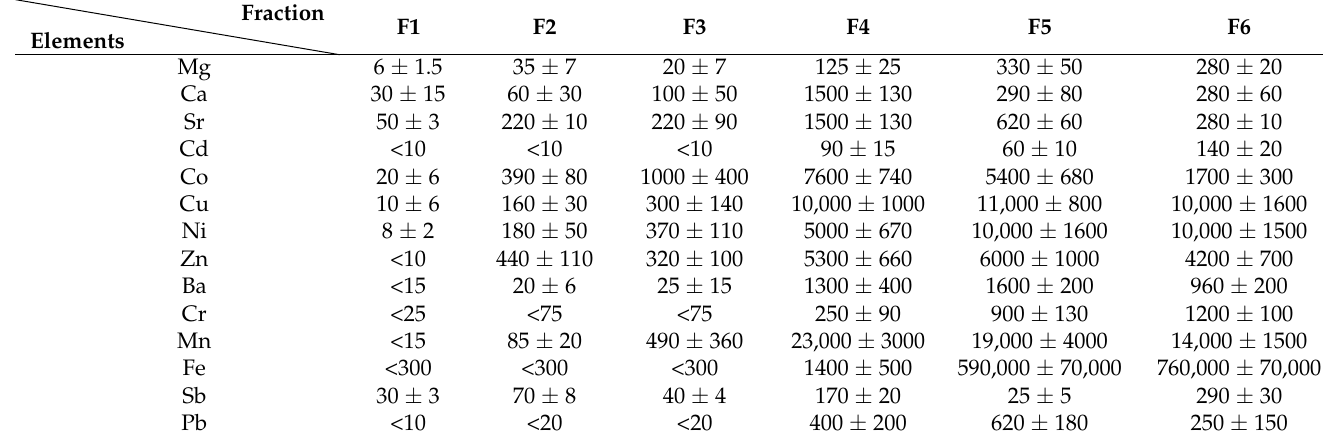
Table 7. Content of cations and metals in leach fraction solutions: Mg and Ca in mg/L and Sr–Pb in µ g/L.